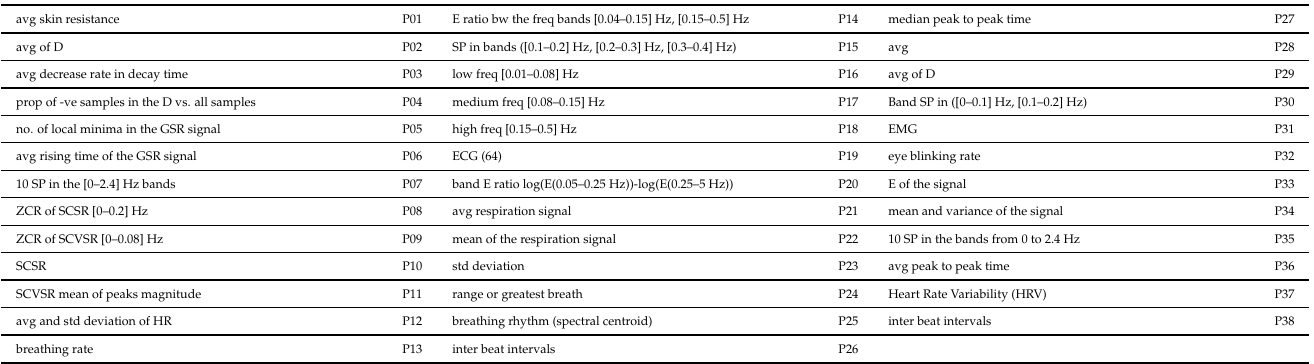
Table 5. Physiological signal